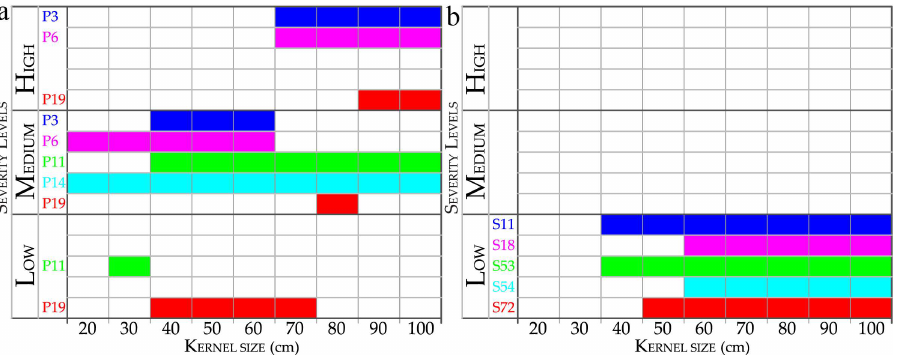
Figure 16. Classification into severity levels of the identified distresses (according to Standard ASTMD6433) as the kernel size changes. (a) Potholes. (b) Swells/shoves.